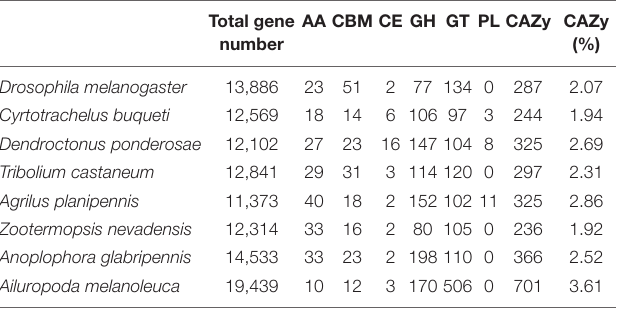
TABLE 4 | Identification and comparative analysis of cellulose degradation enzyme gene between Cyrtotrachelus buqueti and other related species’ genomes.